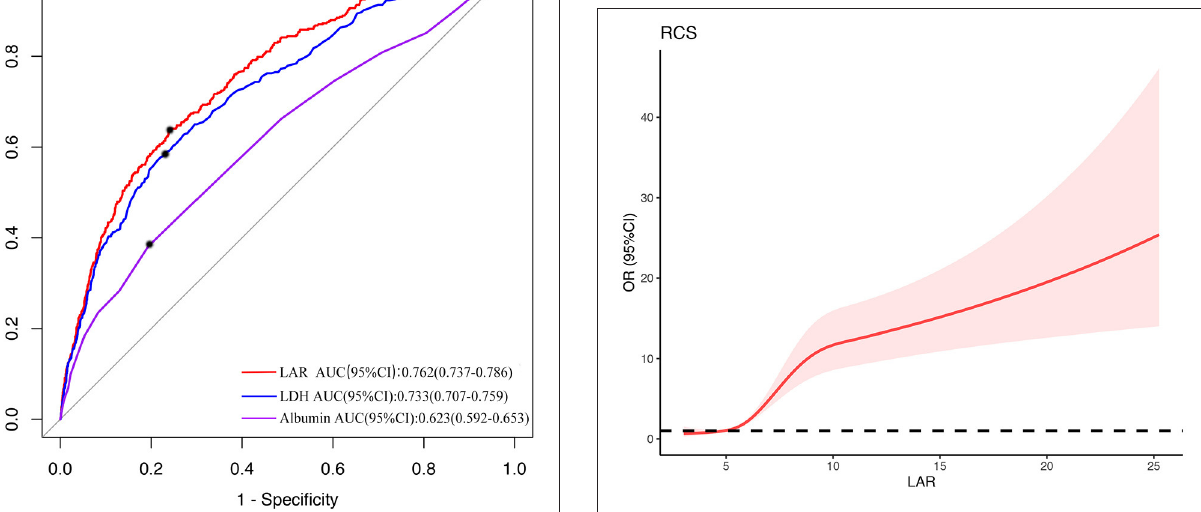
FIGURE 2 | The ROC curve of LAR in predicting the incidence of SAP. The area under the ROC curve (AUC) shows the predictive ability of LAR. The AUC was 0.762 (95% CI 0.737–0.786) of LAR in predicting the risk of SAP. LAR, Lactic dehydrogenase to albumin ratio; AUC, Area under the curve; SAP, stroke-associated pneumonia; ROC, The receiver operating characteristic.